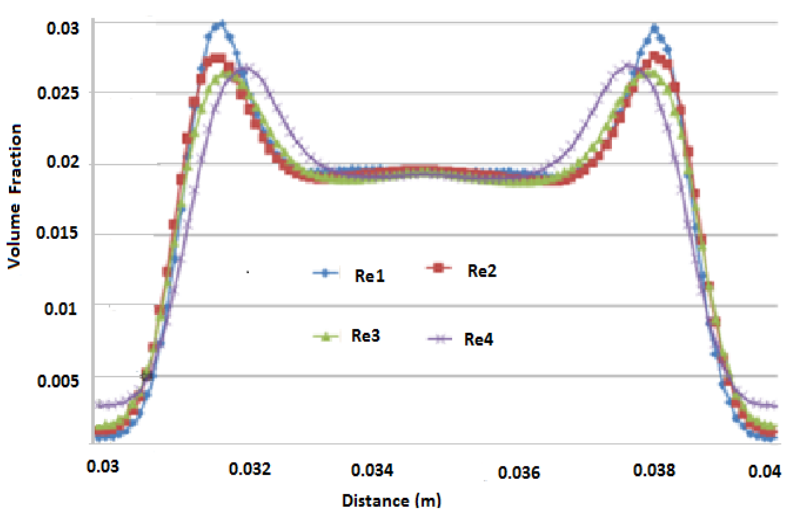
Figure 5. Variation of solid phase volume fraction (for W 9 slurry) for different slurry velocities at constant RPM of inner wall along plane